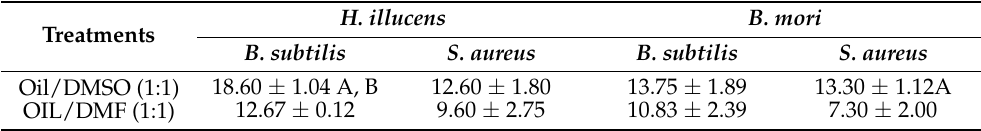
Table 5. The inhibition growth-halo measurements (mm) obtained with agar diffusion